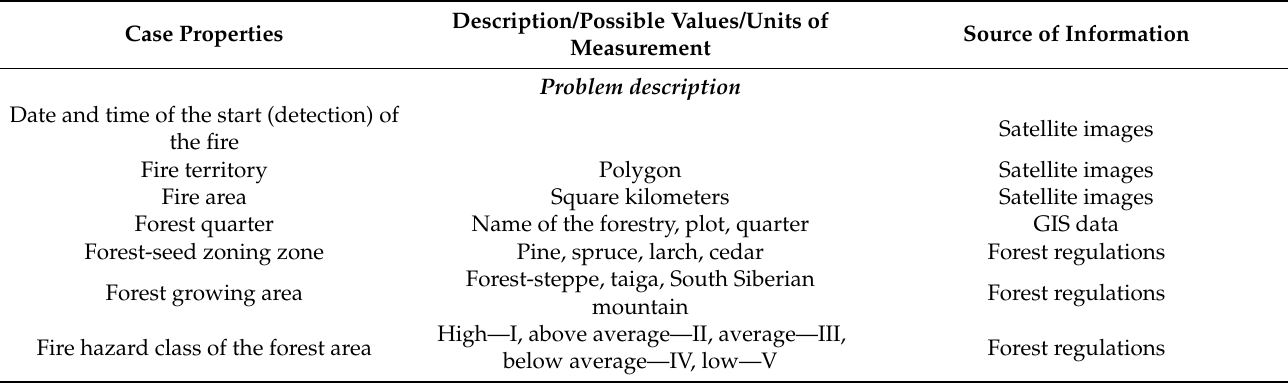
Table 2. Properties of a case